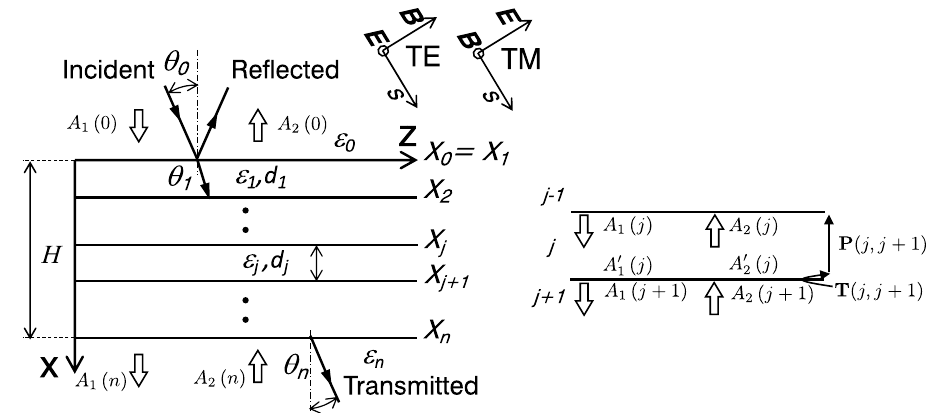
Figure 2. An n + 1 media structure ( n − 1 layers) of snowpack of height H . The relative dielectric permittivities are, in general, complex magnitudes. The upper and lower media are semi-infinite.